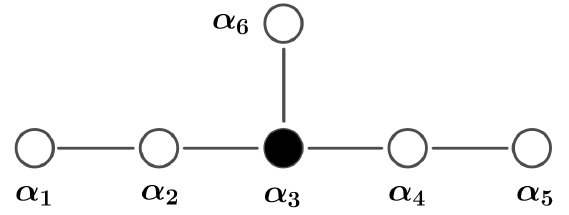
Figure 4 . E 6 Dynkin diagram, with the root blown up in the length three flop colored in black.